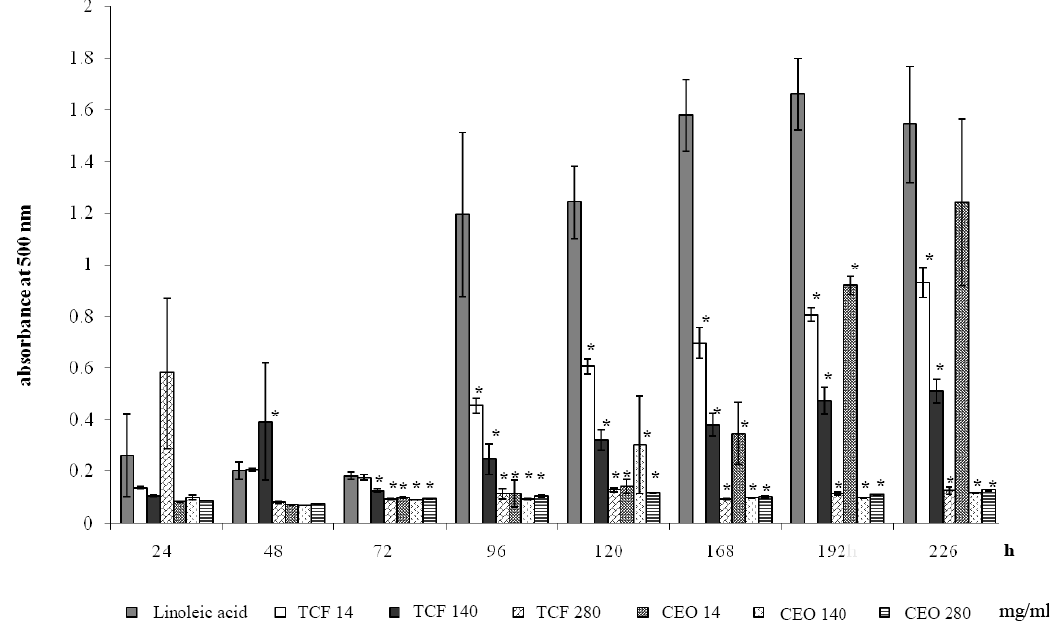
Figure 2. Total antioxidant activity of  -tocopherol and chamomile essential oil (CEO) evaluated with the ferric thiocyanate assay. TCF =  -tocopherol. * Statistically significant difference with respect to the value of the linoleic acid group. ANOVA and Student t tests, p <